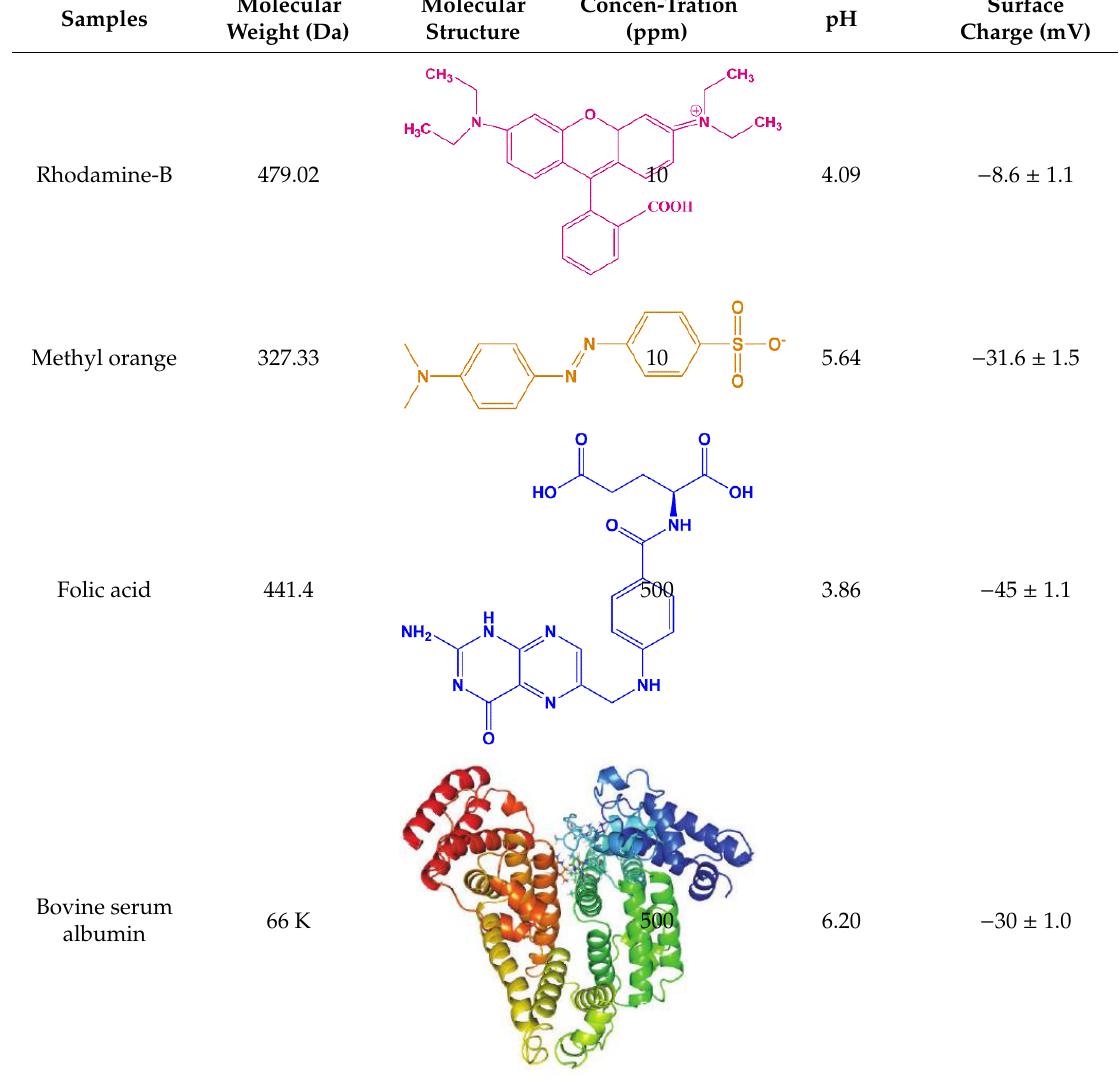
Table 1. Molecular structure, pH, particle size and surface charge analysis of Rh-B, MO, FA and BSA molecules. Samples